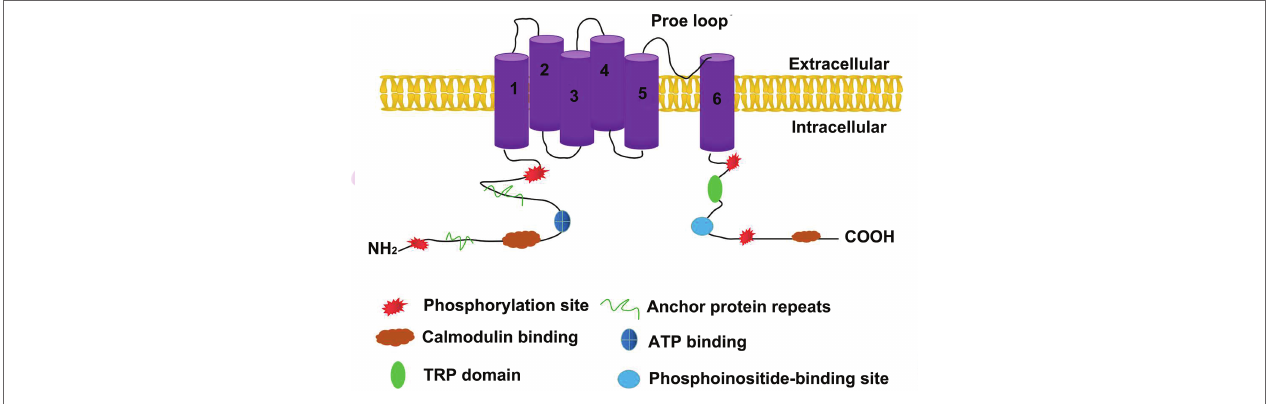
FIGURE 1 | The structure of TRPV1. TRPV1 is a protein with six transmembrane regions, the fifth transmembrane protein region and the sixth transmembrane protein region of each subunit aggregate together to form a pore region for the TRPV1 channel. The amino-terminal and carboxy-terminal of TRPV1 are both intracellular.There are three anchor protein repeats and multiple phosphorylation binding sites at the N-terminus, which can bind to calmodulin and ATP. The N-terminal intracellular region contain TRP domain,calmodulin-binding sites and phosphoinositide-binding